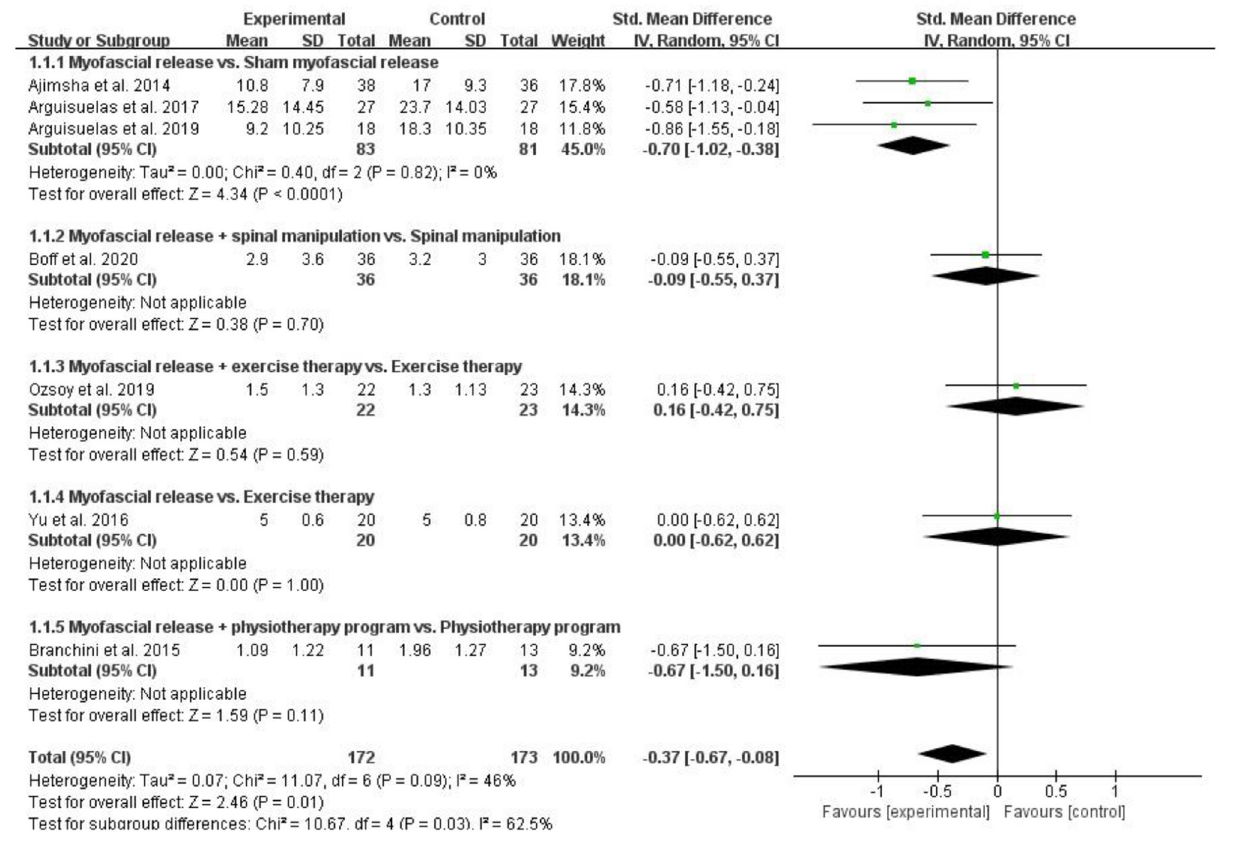
FIGURE 3 | Meta-analysis on